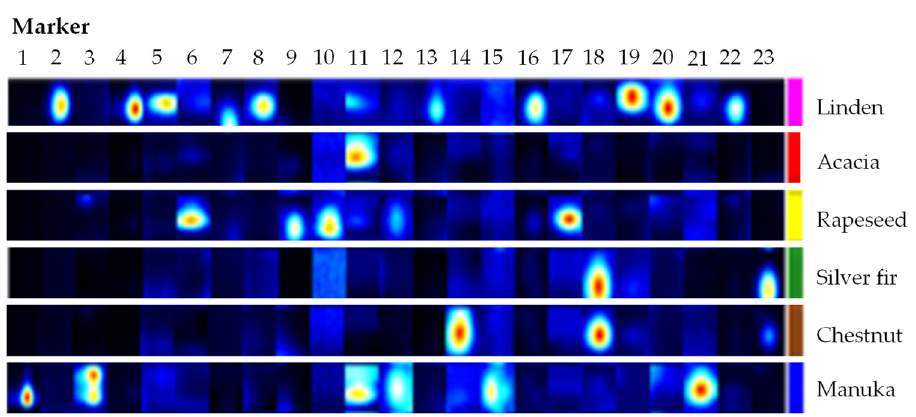
Figure 2. Gallery plot of 23 marker signals for linden, acacia, rapeseed, silver fir, chestnut and manuka type honey.